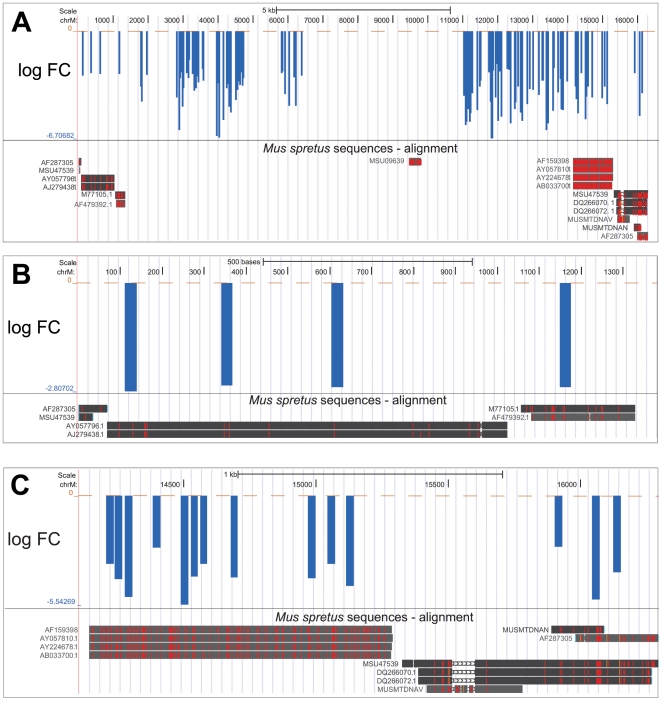
Downregulation of probes within the mitochondrial genome refers to sequence divergence.The individual probes are plotted along the mitochondrial genome coordinates as bars with the height corresponding to the log fold change difference in intensity between Spr and B6. (a) Two tracks are visualized: the upper one shows probes whose difference in intensity between Spr and B6 is significant at P<0.05. Below, the alignment of Mus spretus sequences obtained from GenBank (http://www.ncbi.nlm.nih.gov/Genbank/) to the B6 sequence is shown and positions of nucleotide differences are highlighted in red or orange. Red bars refer to SNPs and the orange color refers to insertion in the Spr sequence. Alignments are shown in detail in (b) and (c). The tracks were created using UCSC genome browser [50].